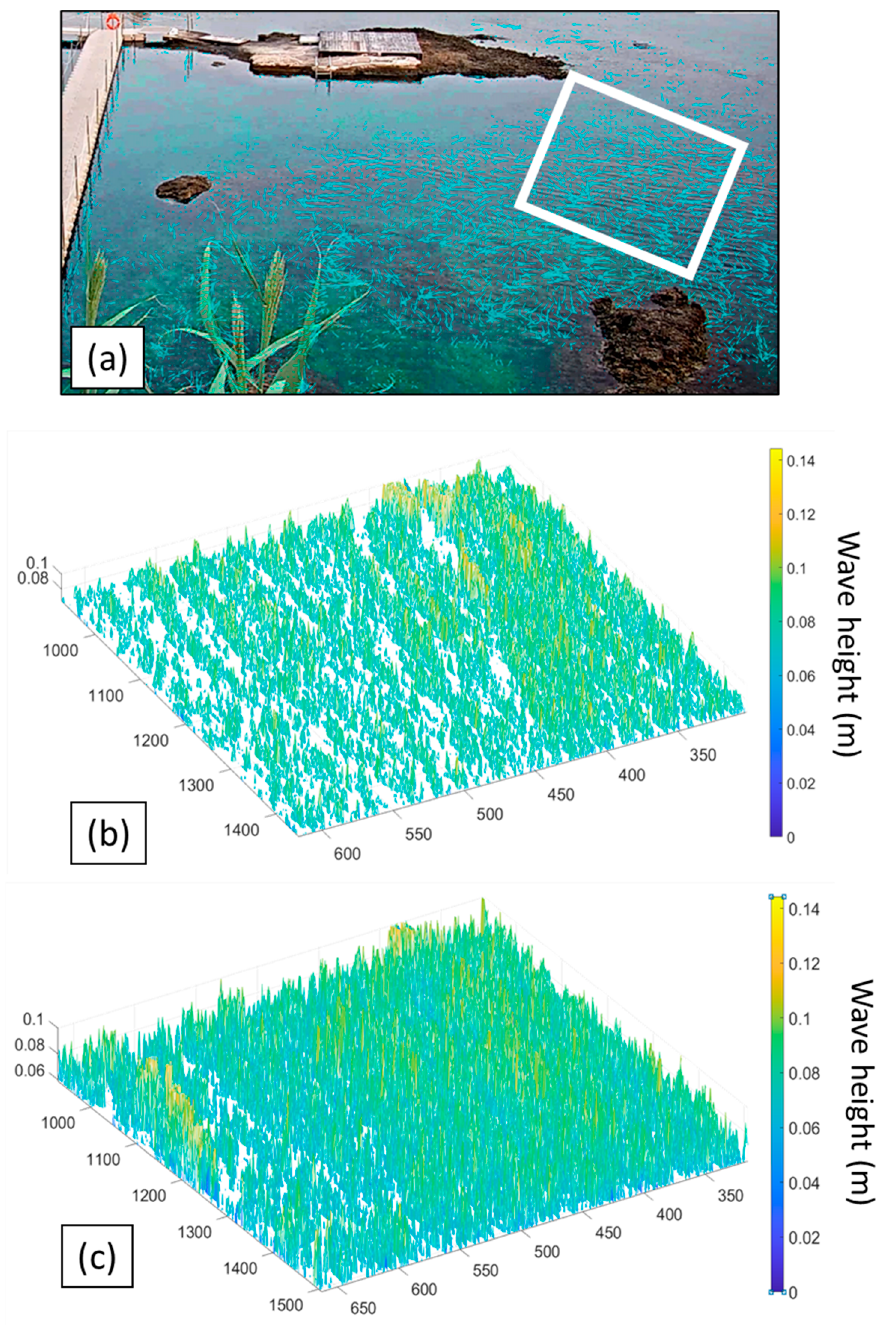
Figure 10. Wave parameters assessed on Massolivieri; ( a ) flow vectors assessment through Optical Flow Farneback technique, the white inset represents the area of interest for the wave height assess- ment; ( b ) wave height assessment through linear relationship (1) in the white inset; ( c ) breaking-wave height assessment through relationship (2) in the white inset.